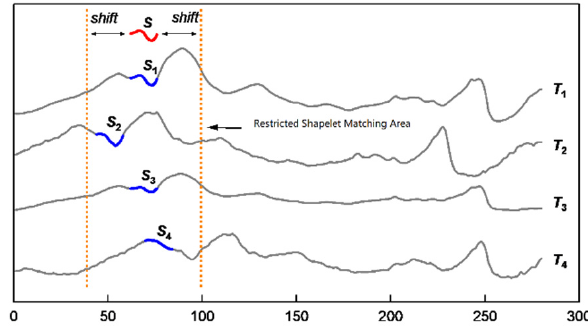
Figure 3. Illustration of Shapelet matching under restriction.